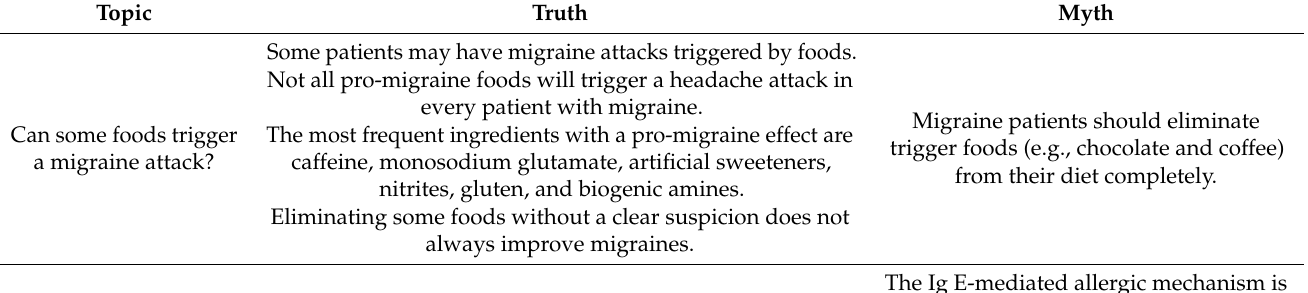
Table 1. Main “truths” and “myths” in the migraine–nutrient